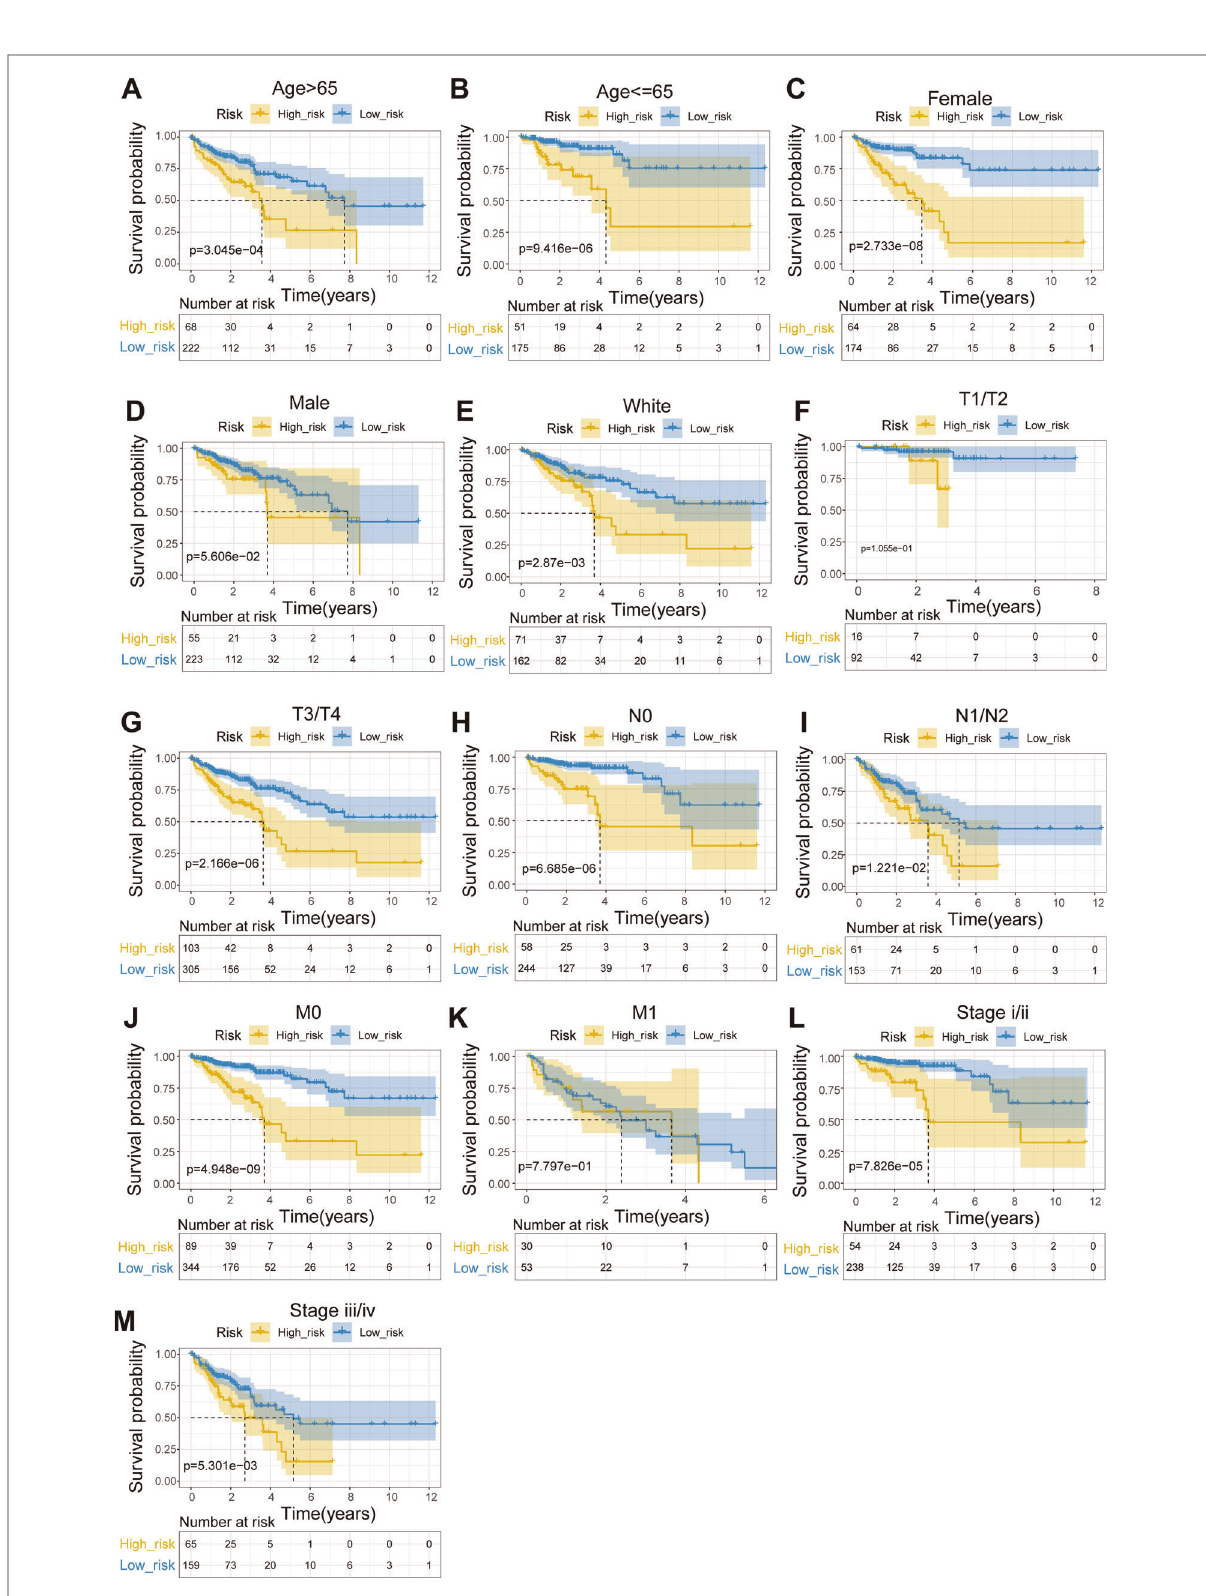
FIGURE 4 Strati fi ed survival analysis of subgroups with different clinical parameters. ( A ) Age>65. ( B ) Age ≤ 65. ( C ) Female. ( D ) Male. ( E ) White. ( F ) T1/T2. ( G ) T3/ T4. ( H ) N0. ( I ) N1 – N2. ( J ) M0. ( K ) M1. ( L ) Stage I/II. ( M ) Stage